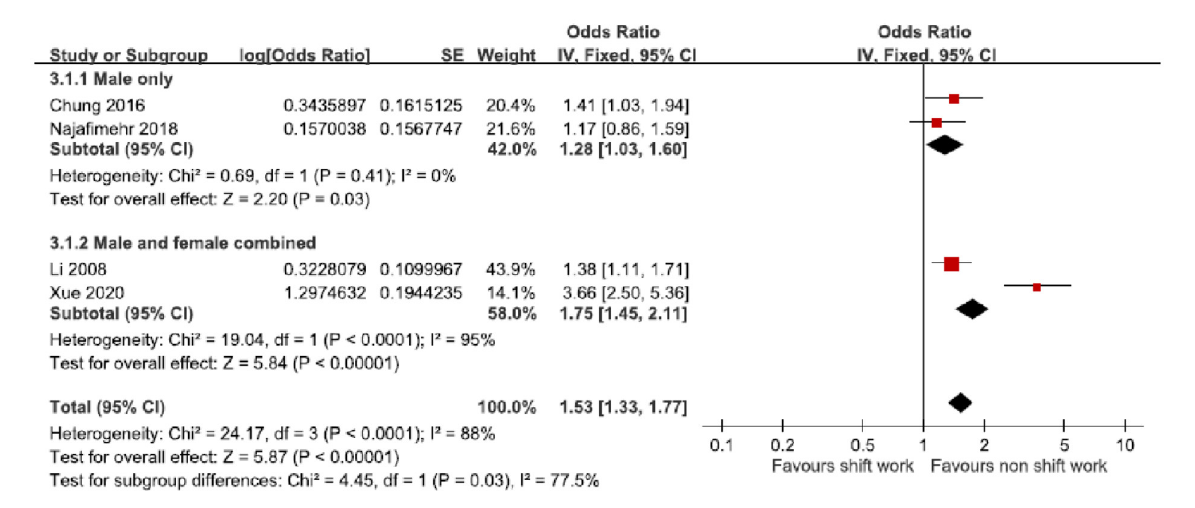
FIGURE5 Subgroup analysis of odds ratios of possible GERD based on different genders.